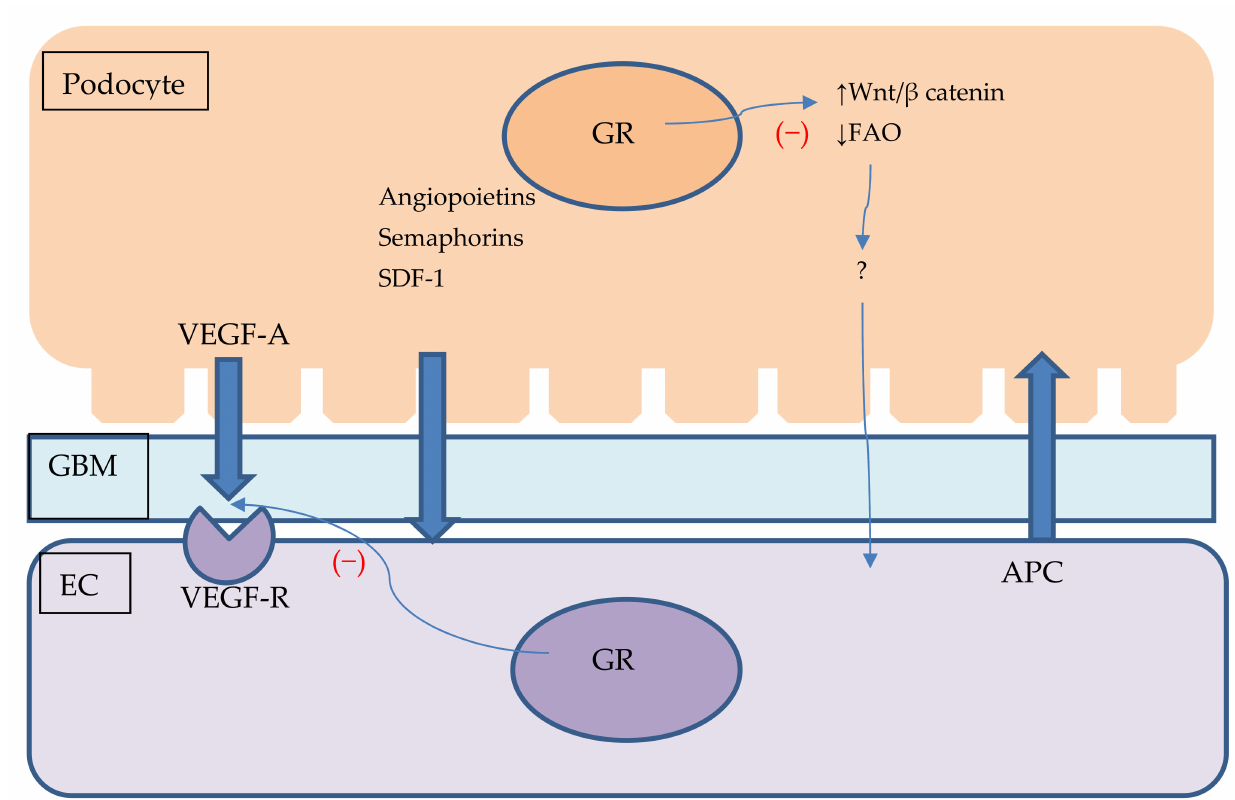
Figure 2. Podocyte–endothelial crosstalk and its potential connection with GR signalling. Figure shows podocyte and endothelial cell with glomerular base membrane between them. Podocytes produce VEGF, angiopoietins, semaphorins and SDF-1 which are secreted and influence endothelial cells homeostasis. ECs might secrete APC which protects podocytes against apoptosis. GR stimulation might impair VEGF signalling and influence podocyte Wnt/ β catenin pathway and promote FAO. Lack of GR stimulation in podocytes might damage ECs through unknown mediator. APC—activated protein C, EC—endothelial cell, FAO—fatty acid oxidation, GBM—glomerular base membrane, SDF-1—Stromal cell-derived factor 1 VEGF—vascular endothelial growth factor, VEGF-R—vascular endothelial growth factor receptor, Wnt—Wnt signalling